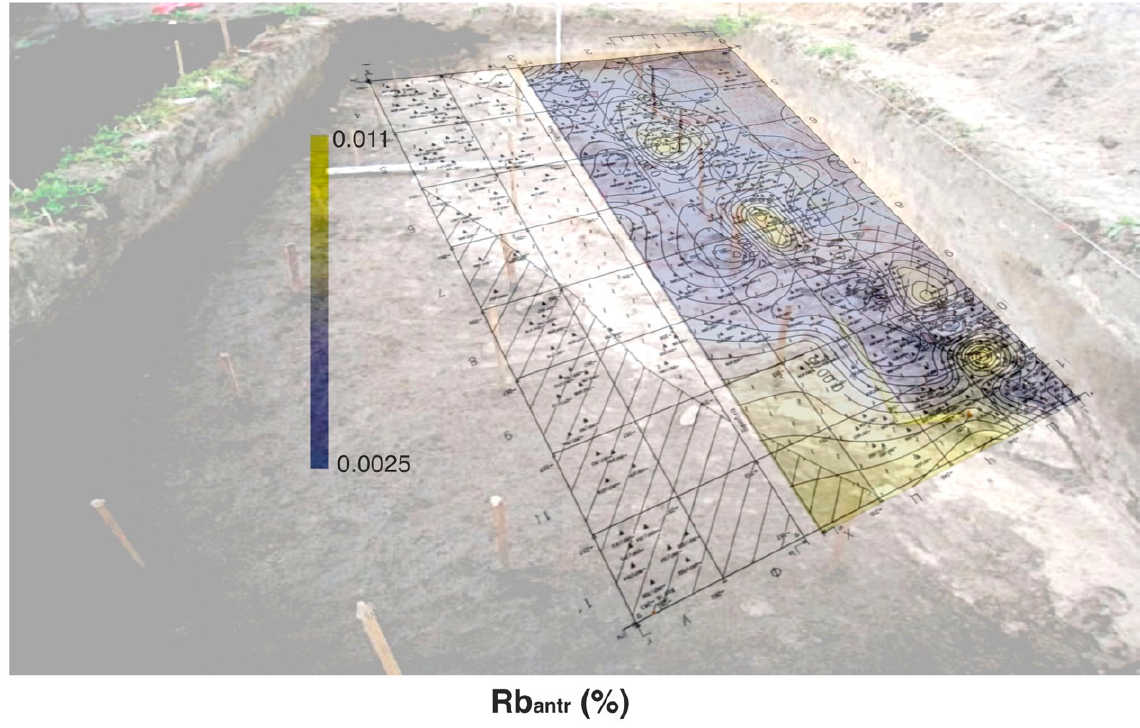
Figure 10. Geochemical map of Rb antr distributions in sediments on the surface of the cultural layer at the Podolye 1 site [38], designed by M.Kulkova.